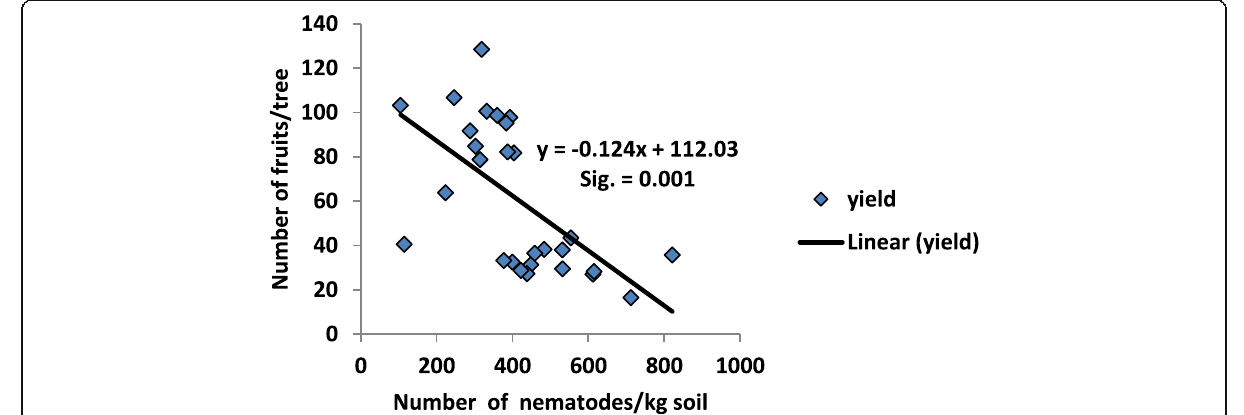
Fig. 2 Relationship between the number of nematodes/kg soil and the number of fig